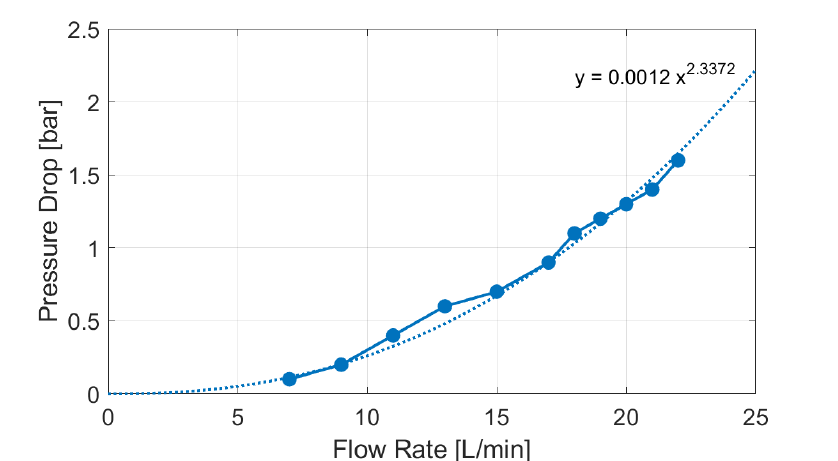
Figure 10. ( Q ÷ ∆ p ) curve of the battery module heat